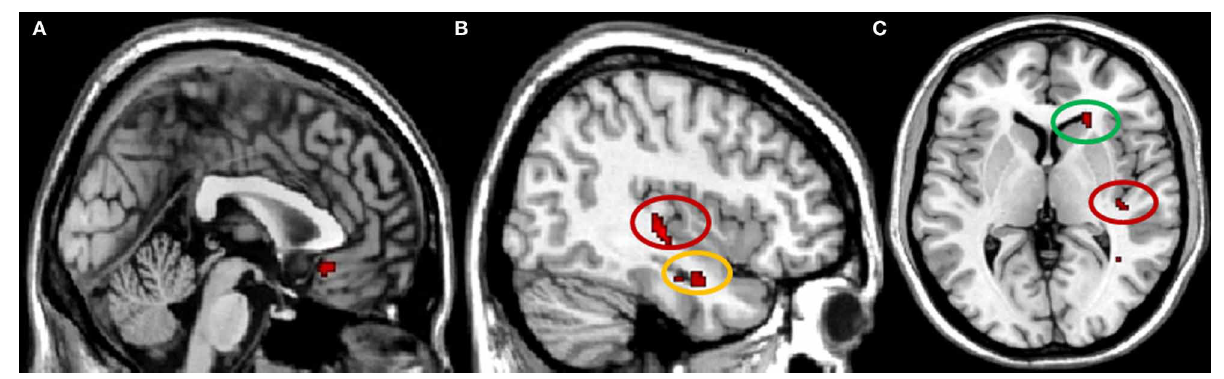
FIGURE 2 | Brain regions involved in in-group conformity, p < 0 . 001 uncorrected. (A) subgenual ACC, x = 0; (B) pSTS/insula (circled in red) and hippocampus (circled in yellow), x = 40; (C) pSTS/insula (circled in red) and caudate (circled in green), z =